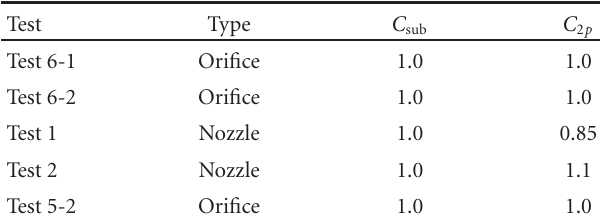
Table 12: Choked flow discharge coe ffi cients used for all break locations, subcooled discharge ( C sub ) and two-phase flow